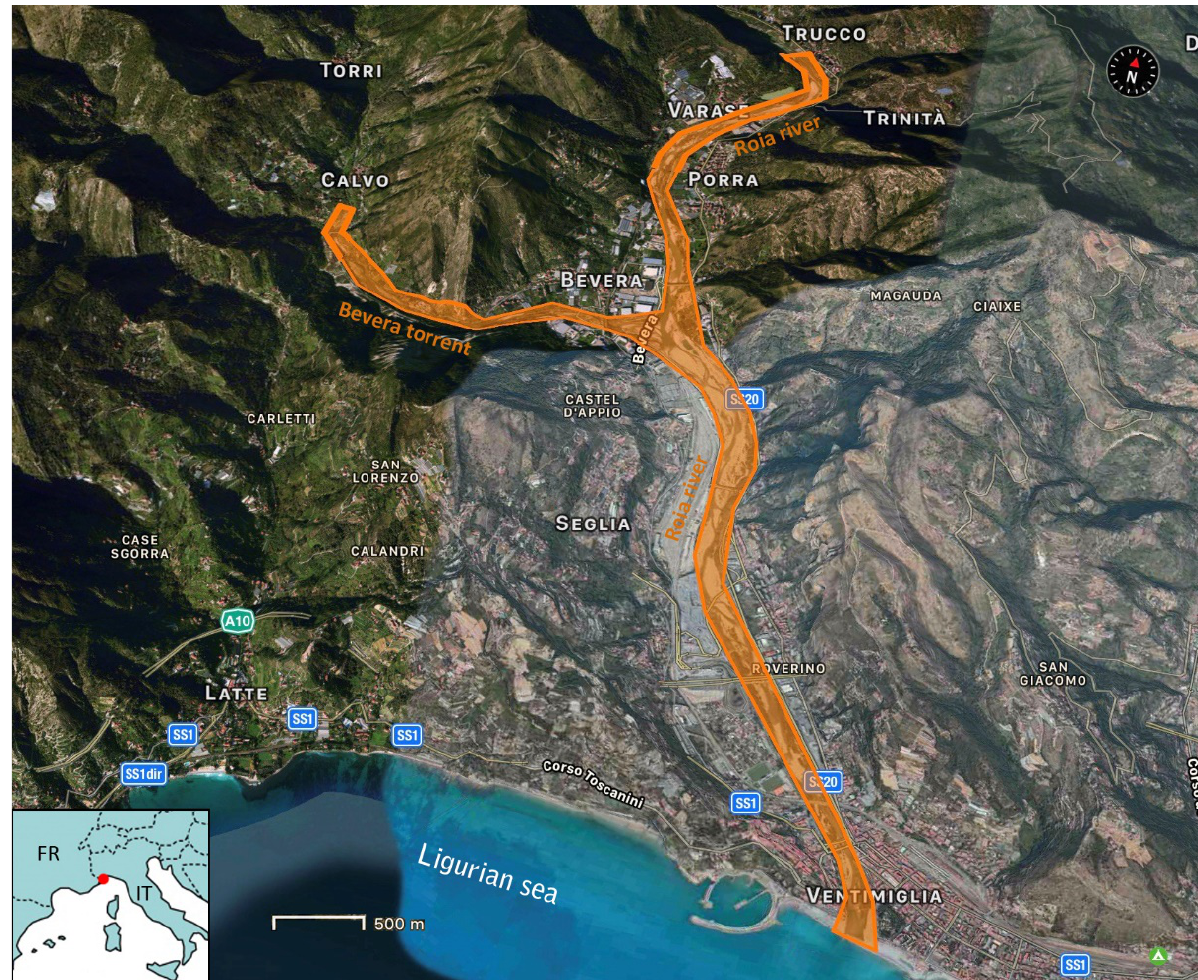
Figure 1. The final stretch of the Roia River, flowing into the sea at the city of Ventimiglia. In orange is the area covered by the unmanned aerial vehicle (UAV) surveys, including the final stretch of the Bevera Torrent. (Image from Apple Maps.)